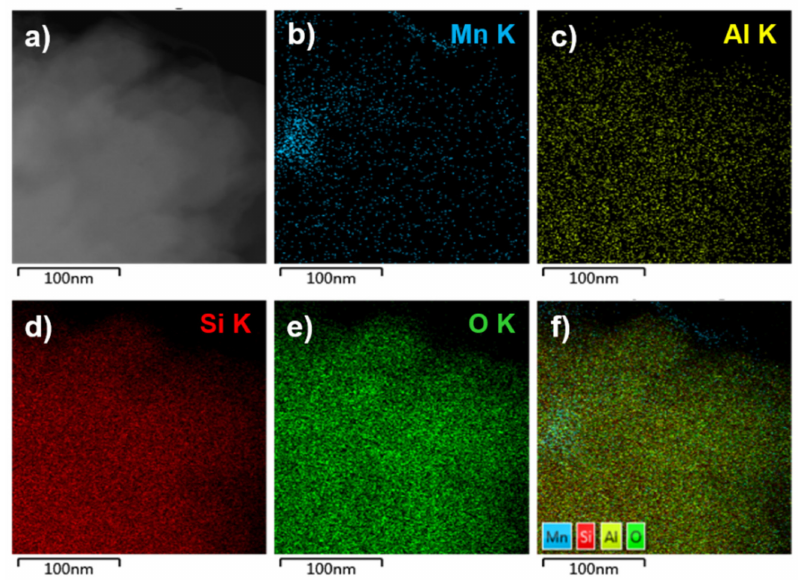
Figure 3. TEM image ( a ) and elemental mapping of Mn ( b ), Al ( c ), Si ( d ), O ( e ), and all elements ( f ) of the MnNC@SAPO-34 sample.